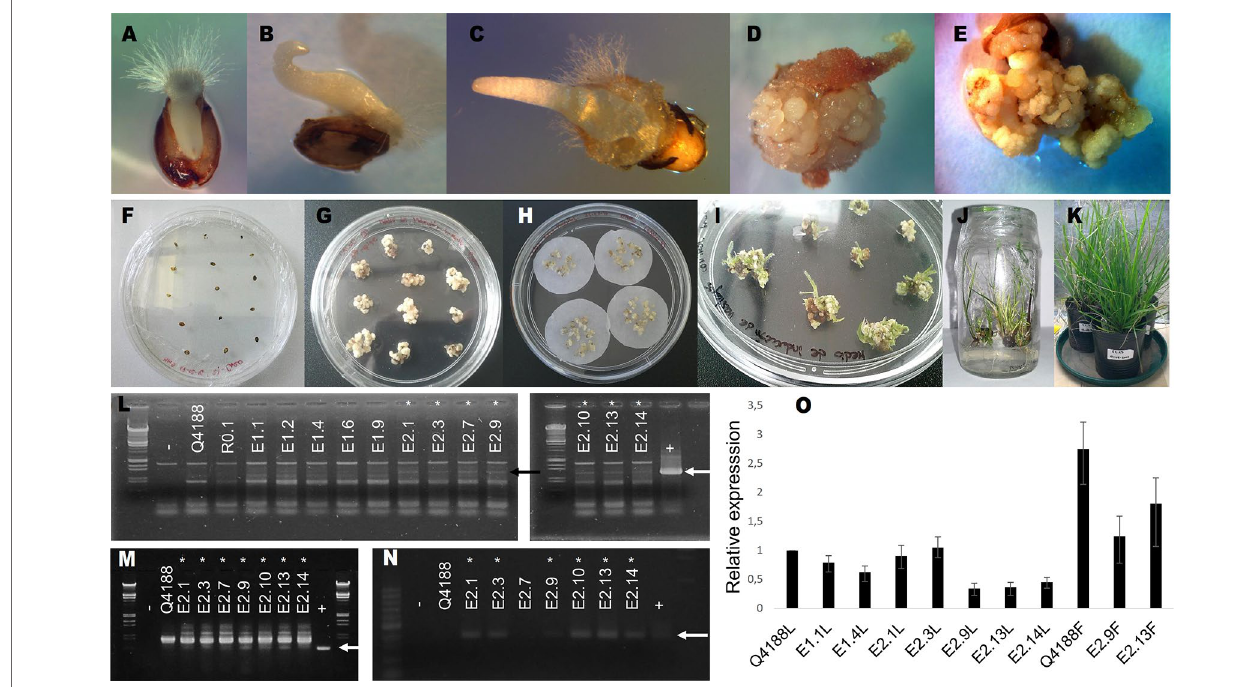
FIGUre 1 | Generation of PN_TGS1 -like antisense lines by biolistic transformation. (A – e) : calli induction sequence; mature seeds in MM5